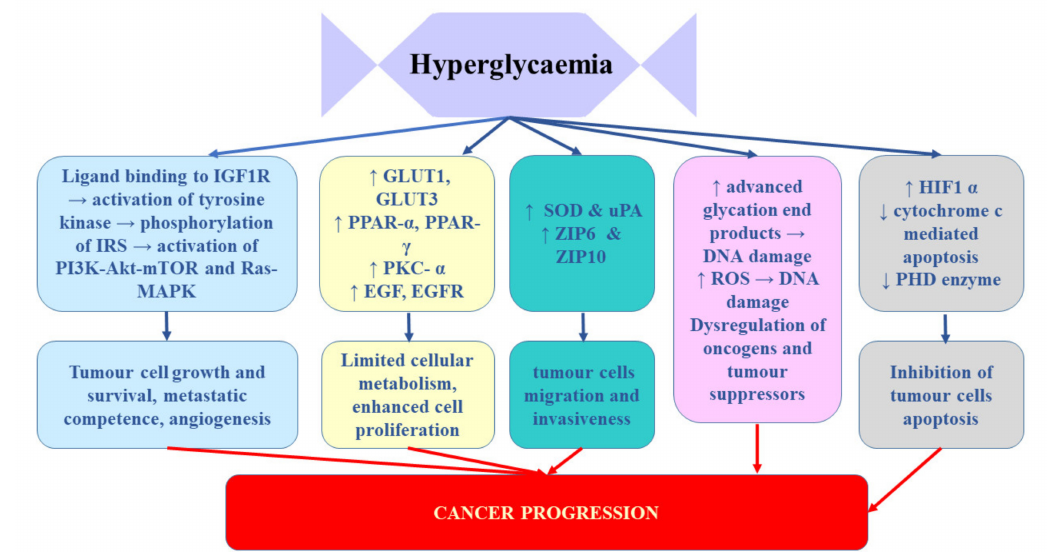
Figure 2. The influence of hypoglycaemia on prostate cancer development and progression. EGF, epidermal growth factor; EGFR, epidermal growth factor receptor; GLUTs, glucose transporters; HIF-1 α , hypoxia-inducible factor-1 α ; IGF-1R, insulin-like growth factor 1 receptor; IRS, insulin receptor substrate; PHD, prolyl hydroxylase domain-containing protein; PKC- α , protein kinase C alpha; PPARs, peroxisome proliferator-activated receptors; ROS, reactive oxygen species; SOD, superoxide dismutase; uPA, urokinase-type plasminogen activator; ZIP, Zrt- / Irt-like